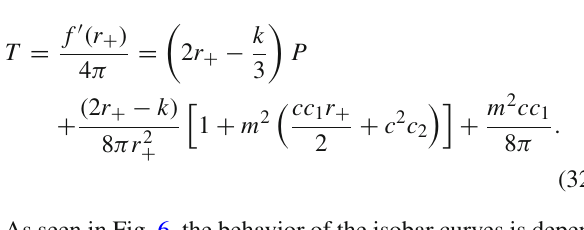
Fig. 5 The mass function is plotted in terms of the horizon radius, at k = 0 . 1 and m = c = − c 1 = − c 2 = 1. Left panel: l = 1. Right panel: l = 0 .